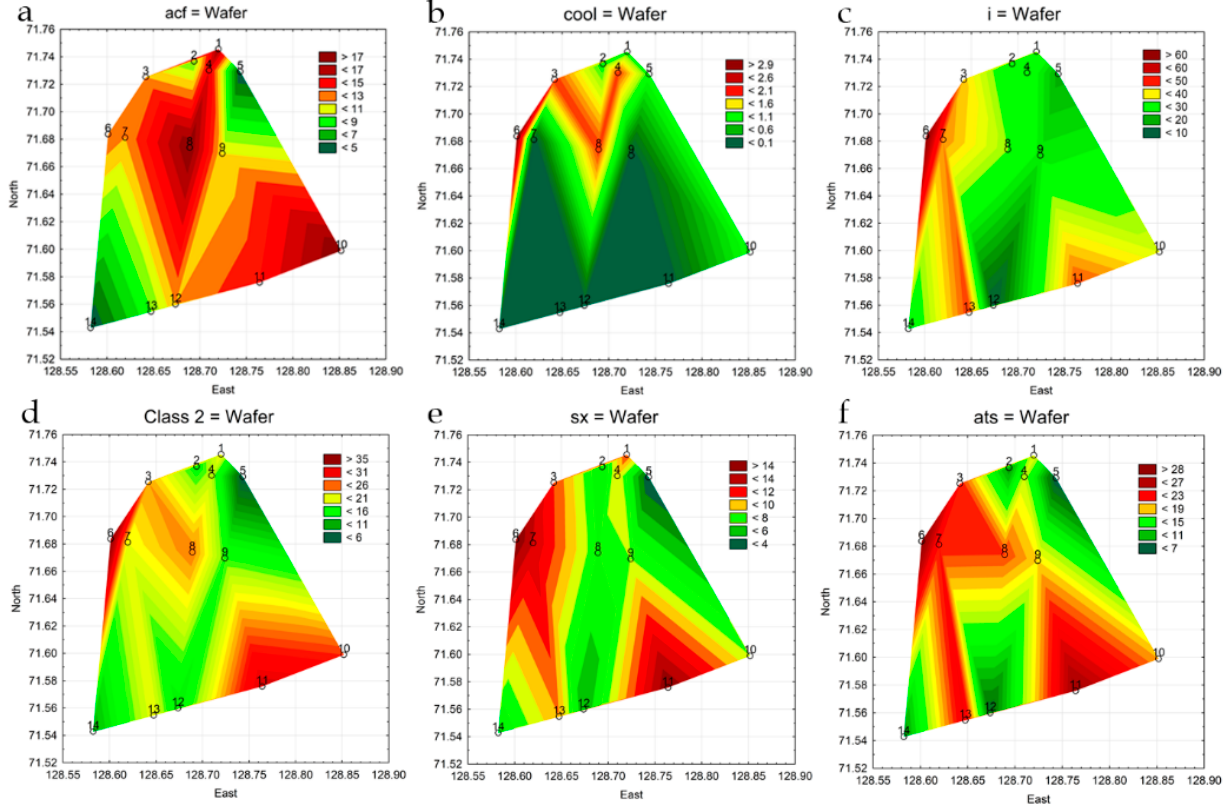
Figure 9. Statistical maps of bioindicator distributions in the 14 studied water bodies: ( a ) acidophiles (acf); ( b ) cool-water indicators (cool); ( c ) oligohalobes-indifferents (i); ( d ) organic pollution